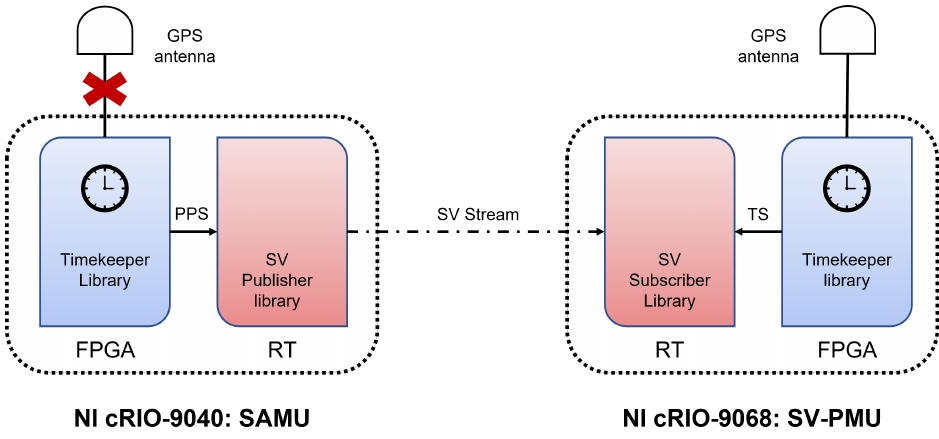
Figure 4. Measurement setup for reproducing the synchronization loss at SAMU